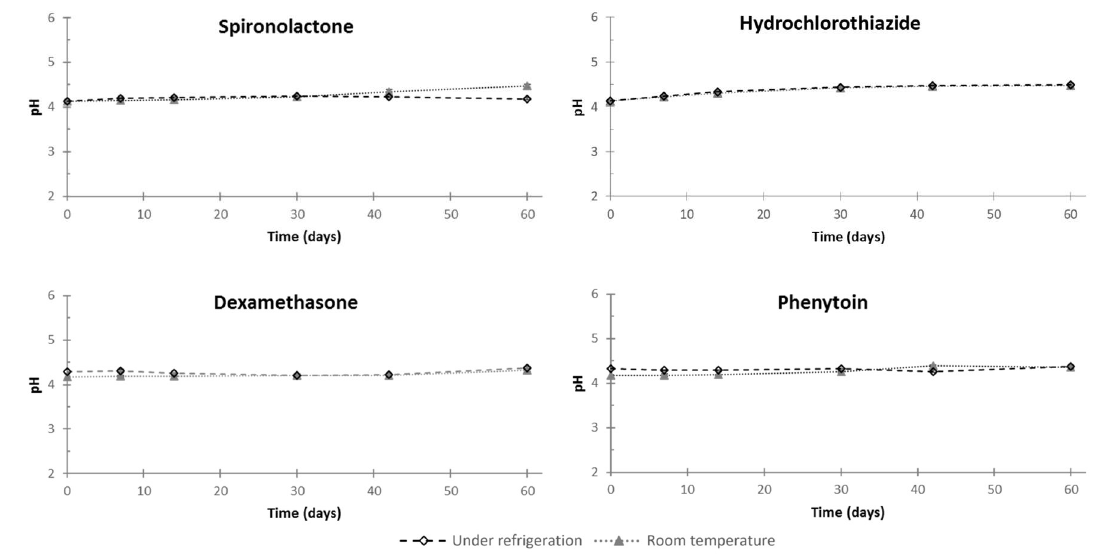
Figure 6. pH modifications of dexamethasone, hydrochlorothiazide, phenytoin, and spironolactone oral suspensions in all storage conditions. Values are expressed as mean ± standard deviation (standard deviation bar charts are within symbols of the mean).